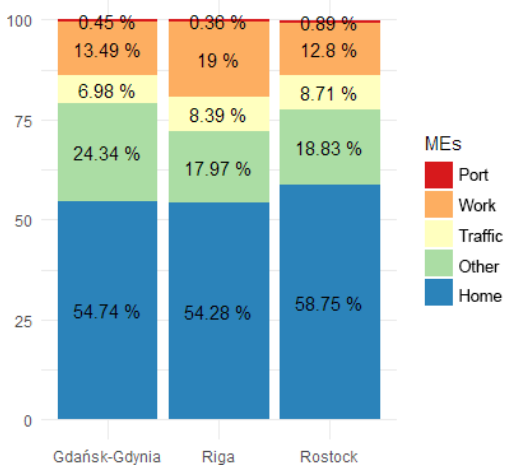
Figure 8. Relative distribution of total exposure in different mi- croenvironments based on total annual averaged grid mean expo- sure to NO 2 in Rostock, Riga and Gda´nsk–Gdynia.